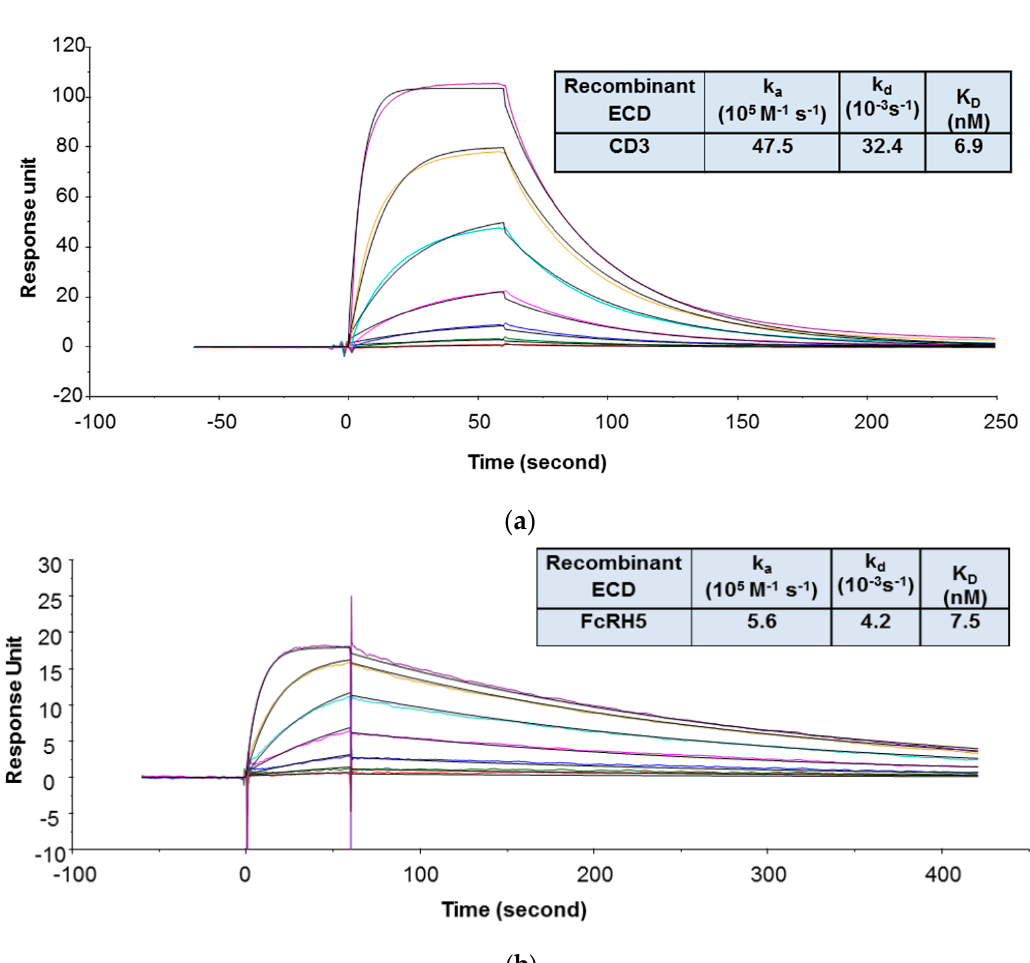
Figure 1. Representative sensorgrams of concentration-dependent binding of 1G7 to recombinant human CD3 ECD ( a ) and FcRH5 ECD (Domain 9) ( b ) at 37 °C. Note: Black solid lines are fitted curves using a 1:1 binding model, and colored lines are the actual data. 1G7 concentrations (from bottom to top) in 1A are 0.08, 0.23, 0.69, 2.06, 6.17, 18.52, and 55.56 nM; recombinant human FcRH5 Domain 9 ECD concentrations (from bottom to top) in 1B are 0.93, 2.3, 5.8, 14.5, 36.2, 90.4, and 226 nM. The sensorgrams were generated after in-line reference cell correction followed by buffer sample subtraction. The kinetics and affinity data in the tables are averaged from three independent experimental SPR runs. Table 3. Characterization of 1G7 binding to FcRH5- and CD3-expressing cells.